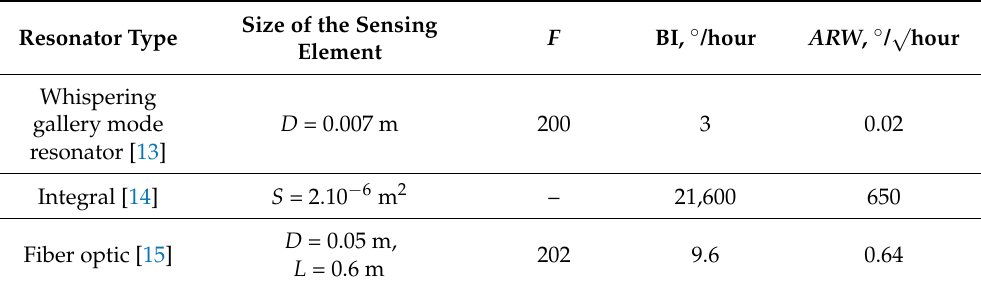
Table 1. A comparative table of accuracy parameters of sensitive elements from various works. Resonator